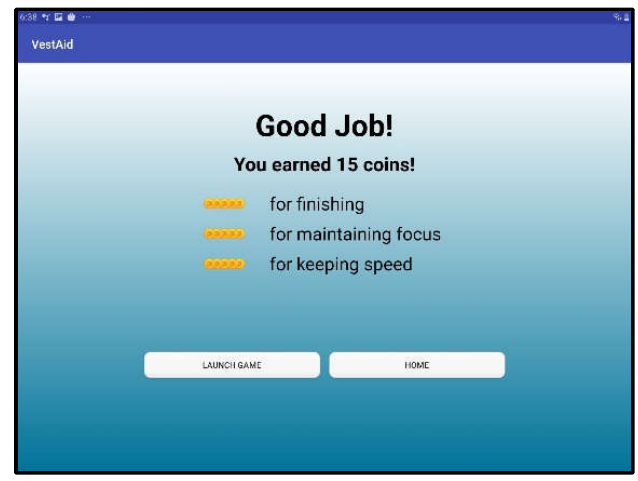
Figure 7. Feedback and reward page.